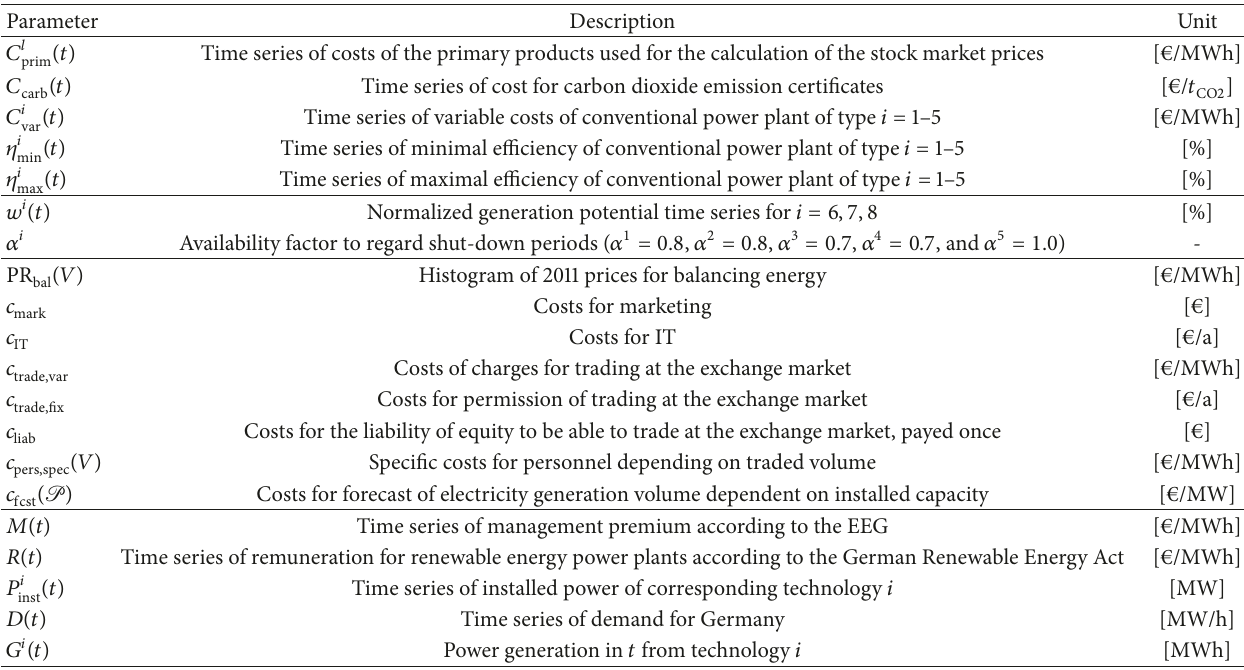
Table 1: External input parameters for the AMIRIS model. 𝑙 indicates the type of the primary product as follows: 𝑙 = 1 : uranium, 𝑙 = 2 : lignite, 𝑙 = 3 : coal, and 𝑙 = 4 : gas. Index 𝑖 defines the power plant type with 𝑖 = 1 : nuclear, 𝑖 = 2 : lignite, 𝑖 = 3 : coal, 𝑖 = 4 : combined cycle gas turbine (CCGT), 𝑖 = 5 : open cycle gas turbine (OCGT), 𝑖 = 6 : offshore wind, 𝑖 = 7 : onshore wind, 𝑖 = 8 : photovoltaics, and 𝑖 = 9 :